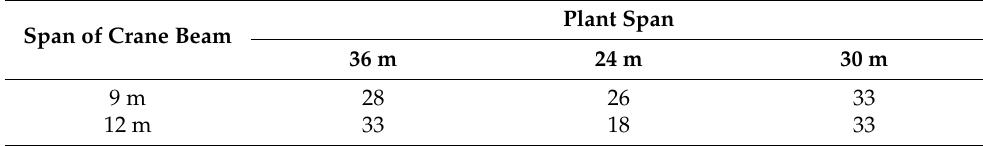
Table 2. Maximum eccentricity of the crane beam track (mm).